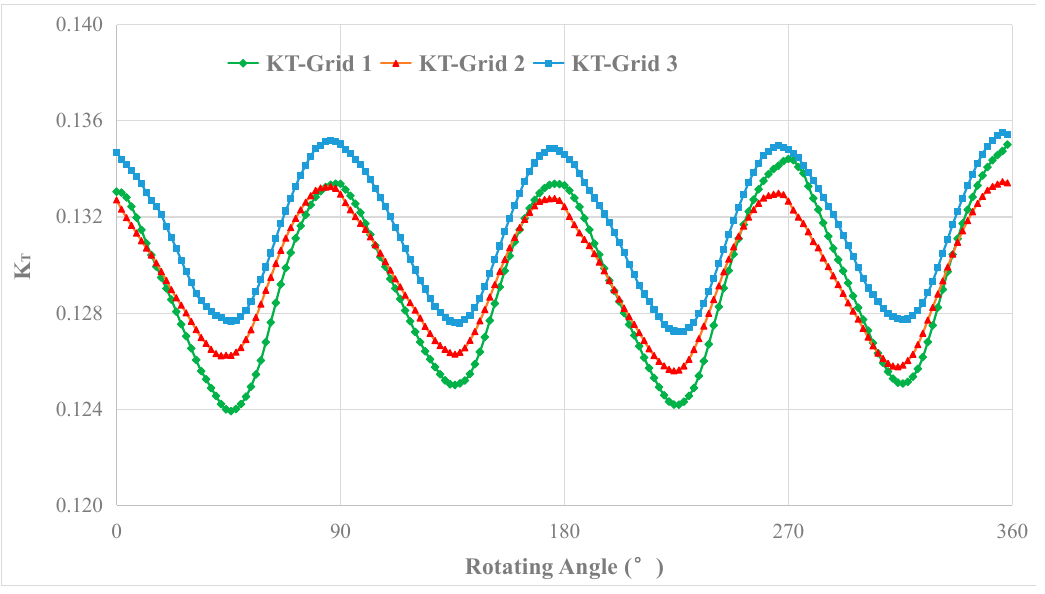
Table 6. The difference between prediction and measurement of K T ; grid uncertainty, U G ; and convergence ratio, R G .